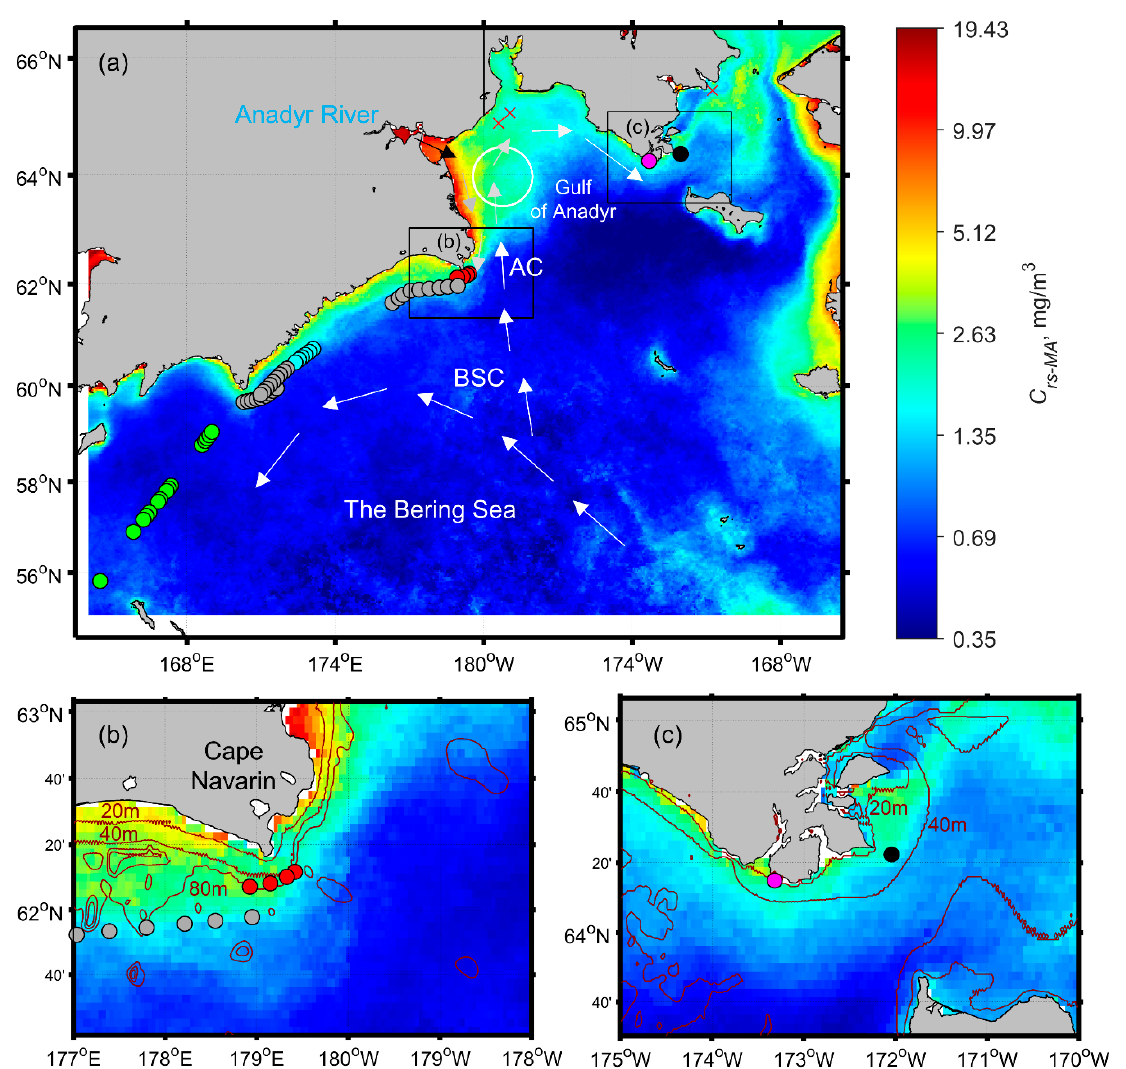
Figure 1. The study area is the western part of the Bering Sea in August 2013: ( a ) the entire study area; ( b ) the region near Cape Navarin; ( c ) the region near eastern part of the Gulf of Anadyr. BSC is the Bering Slope Current and AC is the Anadyr current. Crs -MA is the averaged MODIS-Aqua estimations of chl-a for August in the period 2002–2020. A description of the colors of the dots is presented in Table 3.